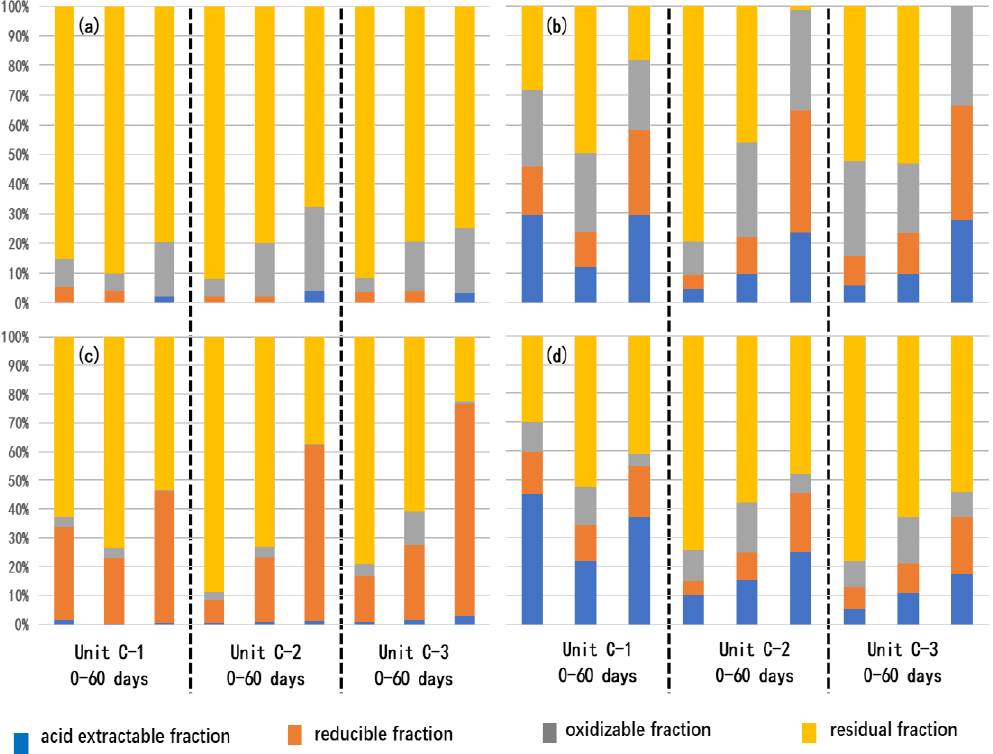
Figure 5. Effect of phyto-stabilization after 30 and 60 days: ( a ) fraction distribution of As after 0, 30, and 60 days; ( b ) fraction distribution of Cu after 0, 30, and 60 days; ( c ) fraction distribution of Pb after 0, 30, and 60 days; ( d ) fraction distribution of Zn after 0, 30, and 60